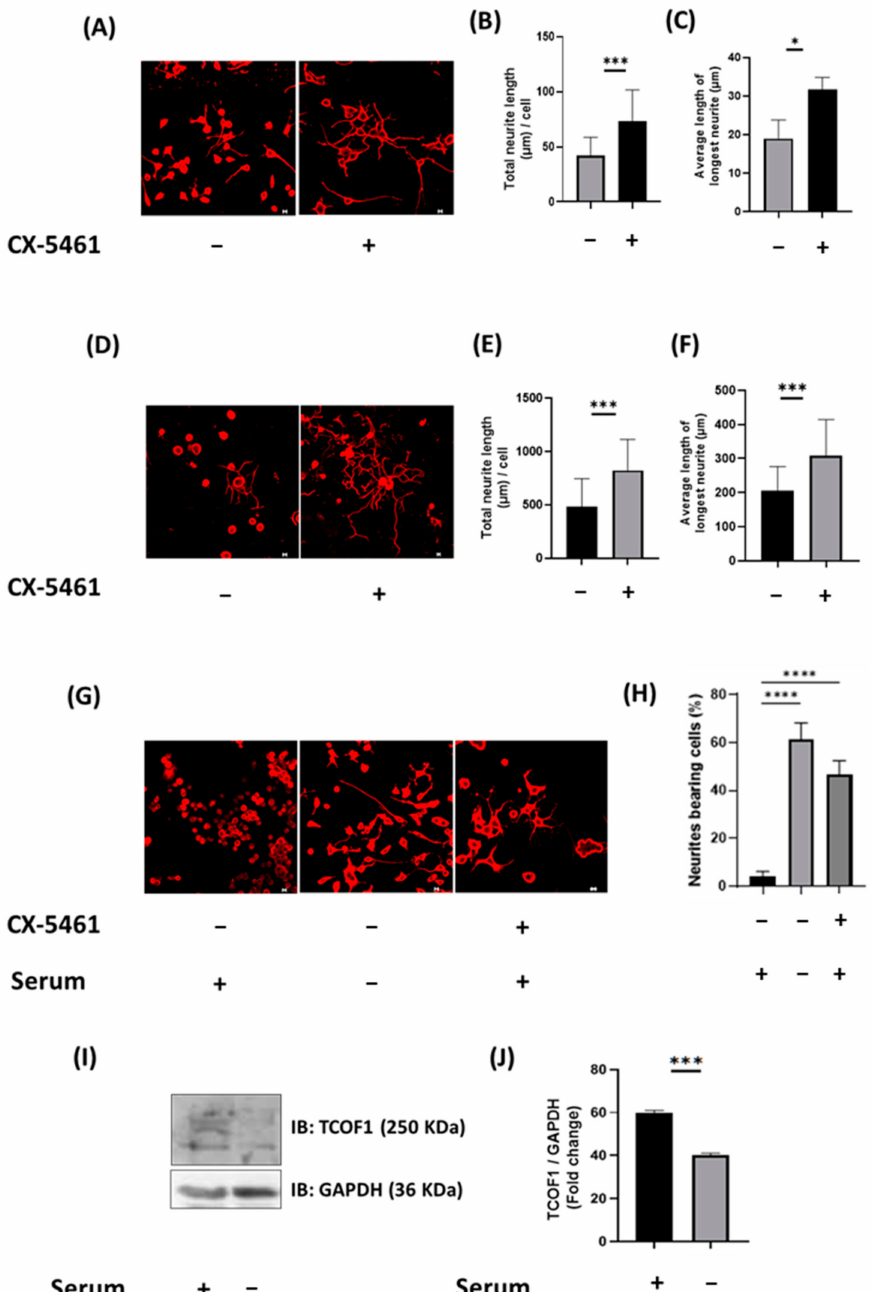
Figure 8. Inhibition of POL I activity enhanced neurite outgrowth in neuro2a cells and DRG neurons. ( A ) Representative confocal images of serum-starved neuro2a cells, 24 h following treatment with 100 nM CX-5461. Scale bars, 10 µ m. ß-tubulin immunostaining was used to determine neurite branching and length. Quantification was done using ImageJ ( B , C ). ( D ) Representative confocal images of cultured DRG neurons 24 h post-treatment with CX-5461. Total neurite outgrowth and the average length of the longest neurite were quantified using ImageJ ( E , F ). ( G ) Representative confocal images of neuro2a cells with or without serum and treated with 100 nM CX-5461. The percentages of cells with neurites were determined and depicted on the bar graphs ( H ). Statistical analysis was performed using Kruskal–Wallis followed by Dunn’s post hoc test. ( I ) Western blot analysis of TCOF1 in serum-starved differentiated vs. undifferentiated neuro2a cells. ( J ) Bar chart representing the protein level of TCOF1 (normalized to GAPDH) illustrated in I. Statistical analysis was performed using Mann–Whitney U test; * p < 0.05; *** p < 0.001; **** p < 0.0001. N = 3 independent